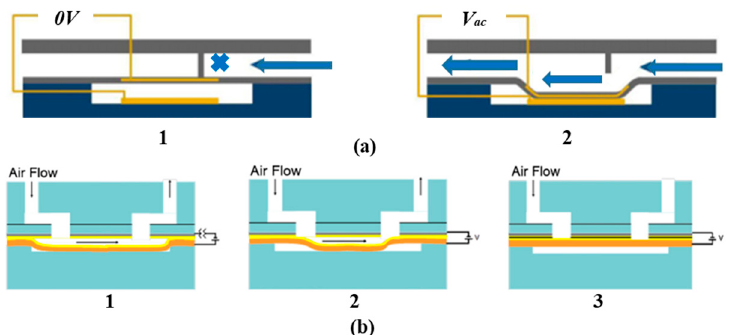
Figure 1. Comparison of the valve operation between normally-closed microvalve ( a ) and normally- opend microvalves ( b ). ( a ) 1 Voltage off, valve fully open; 2 Voltage on, valve starting to close; 3 Voltage on, valve fully closed [30]; ( b ) Operation mode [32].